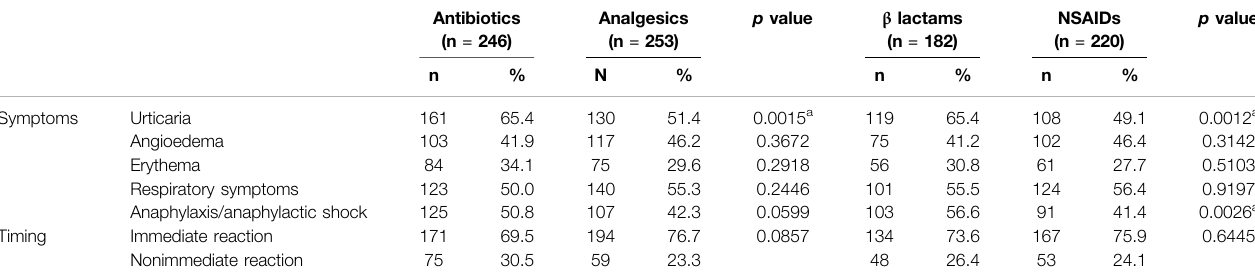
TABLE 5 | Frequency of symptoms and reactions on speci fi c drug allergy is done in con fi rmed allergy